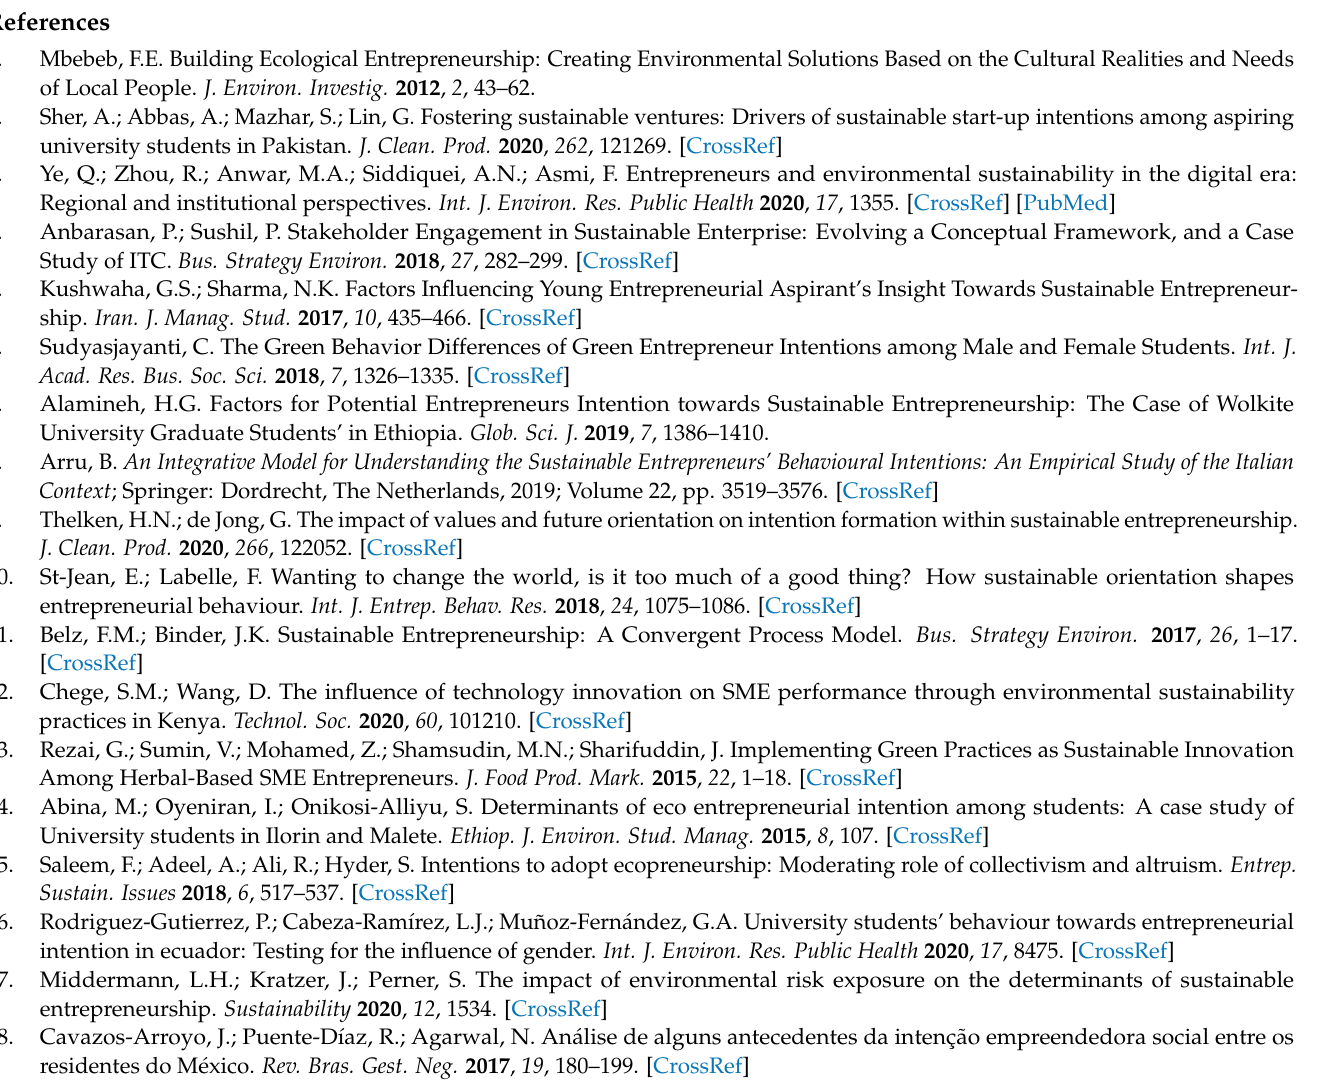
Figure A7. Funnel plot of SE - SEI.